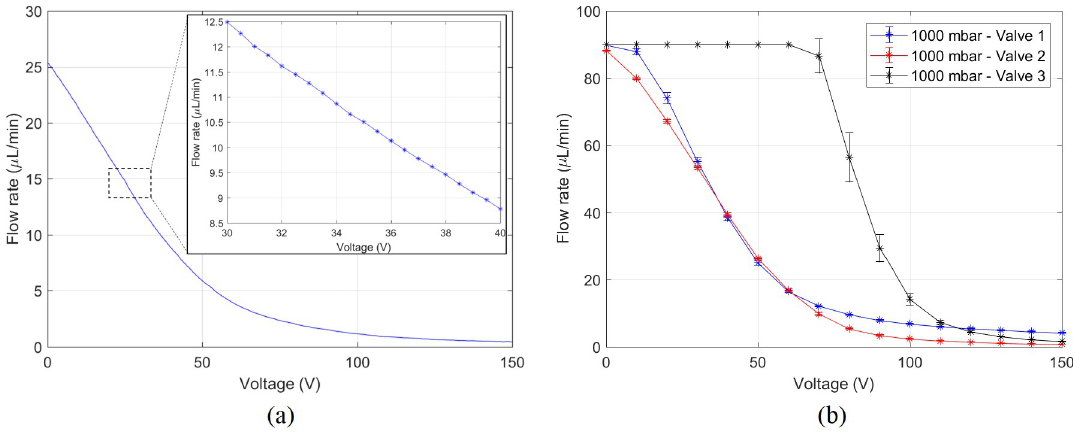
Figure 10. ( a ) Fine control of the microvalve at 500mbar pressure. ( b ) Reproducibility of flow rate behaviour at 1000mbar with three microvalves. The flow sensor has a limit of 90µLmin − 1